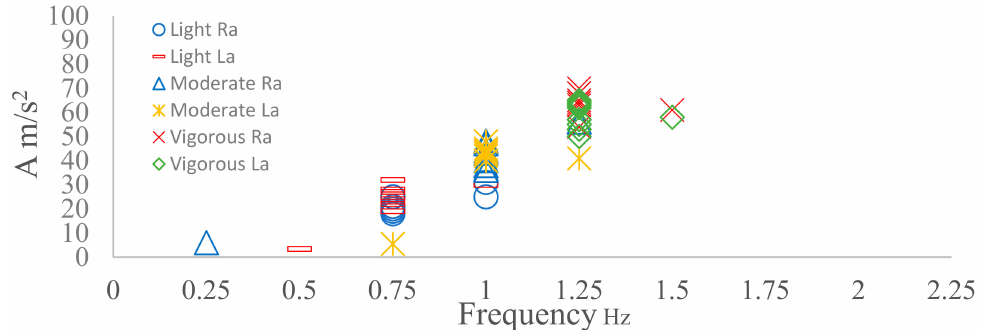
Figure 7. Right and left ankle dominant frequency and amplitude for di ff erent cycling